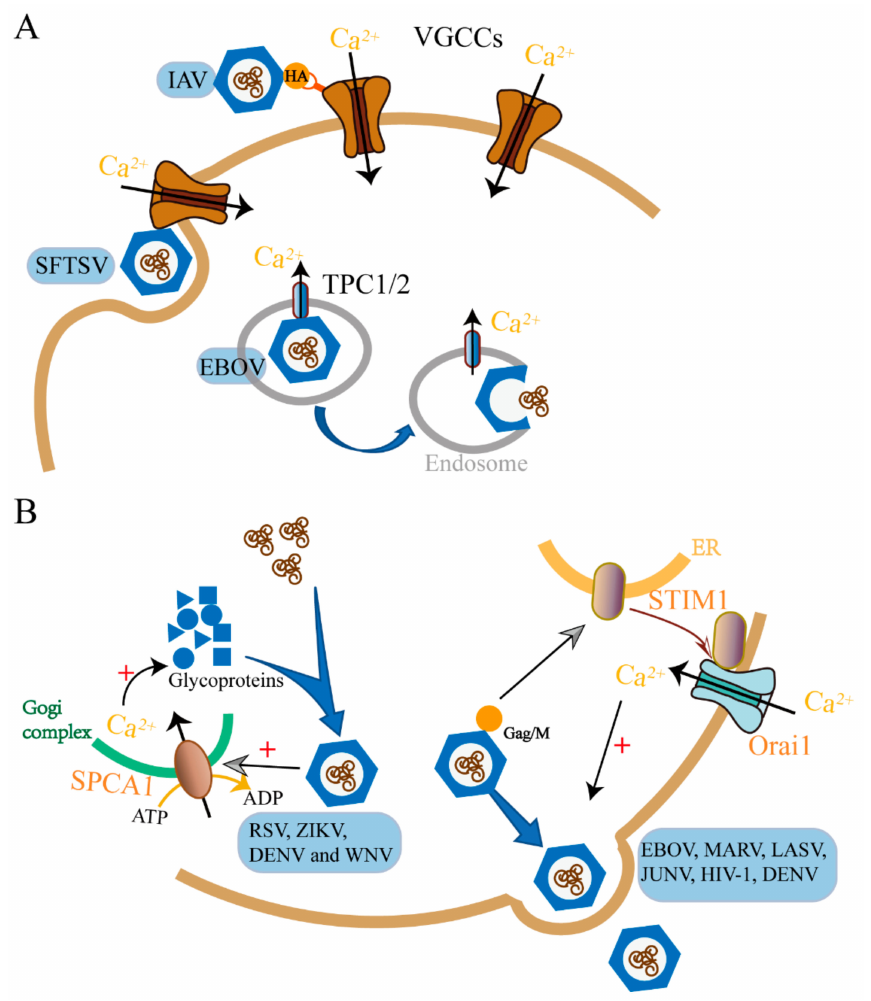
Figure 2. Examples of viruses interplaying with host calcium channels or pumps to achieve viral entry ( A ) and release ( B ). VGCCs are important for influenza A virus (IAV) and severe fever with thrombocytopenia syndrome virus (SFTSV) entry into the host cell as well as TPC1 / 2 for EBOV ( A ). RSV, Zika virus (ZIKA), dengue virus (DENV) and West Nile virus (WNV) hijack SPCA1 to facilitate their release as well as Ebola virus (EBOV), MARV, LASV, JUNV, HIV-1 and DENV manipulates STIM1 / ORAI1 ( B ). For a complete list of definitions, see Table